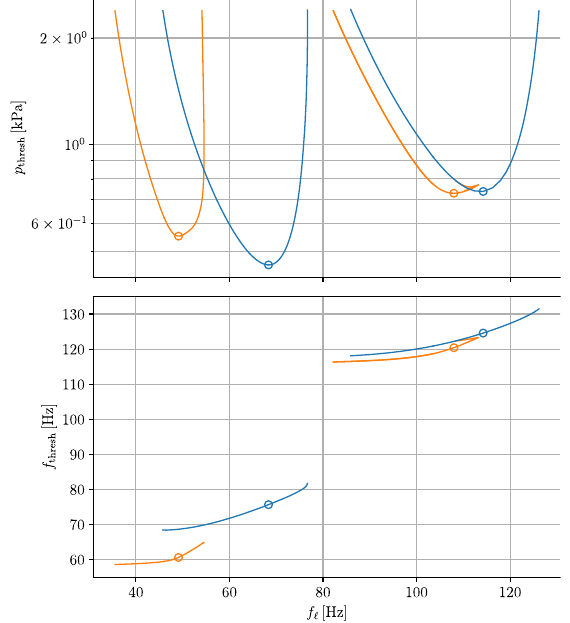
Figure A.1. Top and bottom plots represent respectively the threshold pressures and threshold frequencies given by the linear stability analysis (blue) and the continuation method (orange) versus the lips ’ resonance frequency in the case of a euphonium. The circles identify the value of f l corresponding to a local minimum of blowing pressure. In the case of the second regime, the easiest note playable is given by the minimum of the continuation method (orange curve), since its minimal threshold mouth pressure is lower than the one given by the linear stability analysis (blue curve). The fi rst two regimes on the left of each plot represent respectively the pedal note and the ghost